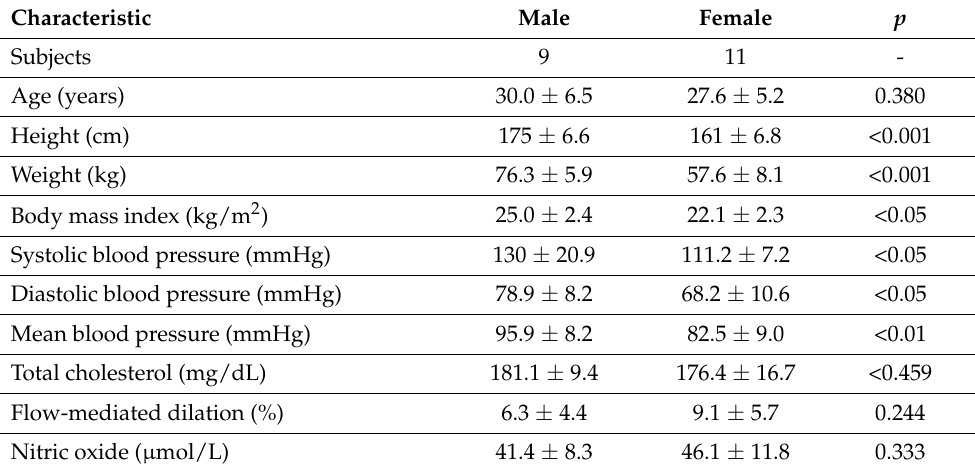
Figure 3. sP-selectin circulating levels in the different sub-populations. Box-and-whisker plots rep- resenting sP-selectin circulating levels (ng/mL) in the overall cohort and in non-smokers, TCCs- smokers and HNBCs-smokers subgroups. 0 = males; 1 = females